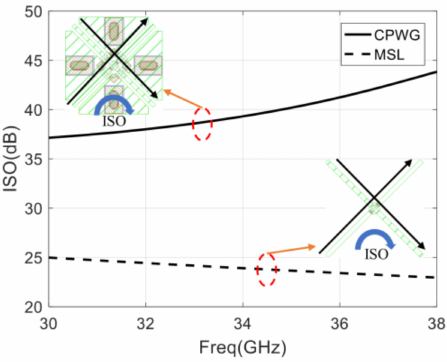
Figure 13. Isolation of the cross-over structure with CPWG and microstrip line.